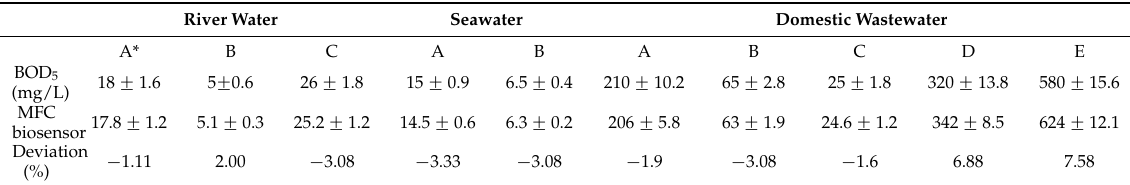
Table 1. BOD measurements by the MFC biosensor and the BOD standard